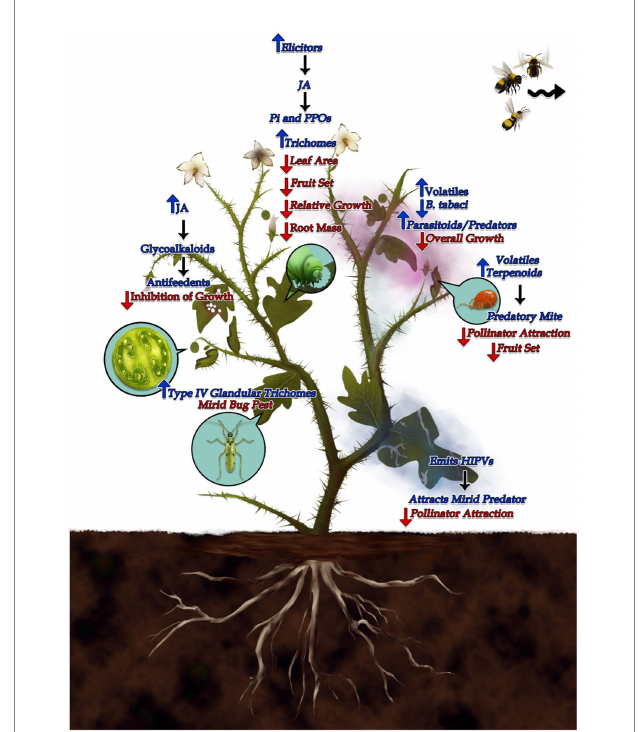
FIGURE 1 Schematic representation of the plant defense mechanisms to the herbivores belonging to different types of feeding guilds and the trade-offs associated with them. As the plant defenses are expensive, plants display a balance between the allocation of their limited resources for growth and defense. Plants under attack of leaf chewing herbivores generally lead to activation of Jasmonic acid signaling pathways which then emits various Herbivore induced plant volatiles (HIPV’s), which can act as antifeedants and also can act as cues for predators or parasitoids. These defensive volatiles can be produced either locally or systemically and can be flavonoids, terpenoids and alkaloids (Wasternack and Parthier, 1997). For instance, plants of family Solanaceae secrete Glycoalkaloids on infested by Leptinotarsa decemlineata , which acts as antifeedant for these herbivores (Pelletier and Tai, 2001). Tomato plants infested by leaf minor, Tuta absoluta emits Herbivore induced volatiles (HIPV) induced by Jasmonic acid, which attracts three mirid predators, Macrolophus basicornis (Stal), Engytatus varians (Distant), and Campyloneuropsis infumatus (Carvalho; Silva et al., 2018). In another example, on infestation by two-spotted spider mite, Tetranychus urticae , the tomato plants emitted volatile tarpenoids which attracted the predatory mite, Phytoseiulus persimilis (Kant et al., 2004). The defenses induced by Jasmonic acid, comes with a cost. Plants on attack by Manduca sexta , increased the levels of JA induced defense chemicals namely, polyphenol oxidase and peroxidase, however it leads to lower fruit set as well as lesser seed set (Redman et al., 2001). Likewise, plants of Solanum carolinense , when treated with Jasmonic Acid, showed lower relative growth, less root mass along with less aboveground mass (Walls et al., 2005). It was reported that the HIPV’s (Herbivore Induced Plant Volatiles) induced in Solanum peruvianum decreased the pollinator attraction and hence less seed set was observed in plants. Moreover, the bees used those volatiles cues to avoid herbivore infested inflorescences (Kessler et al., 2011). When it comes to phloem feeders, the defense signaling is mainly induced by Salicylic acid pathway. For example, plants under attack of aphids, Myzus persicae deter the attack by Bemisia tabaci and emit volatiles which tend to attract various general as well as aphid specific natural enemies (Tan and Liu, 2014). Interestingly, Datura wrighti exhibit a trade-off between plant resistance to whitefly and susceptibility to mirid bug, Tupiocoris notatus where the glandular trichomes inhibit the colonization of whitefly but increases the oviposition by T. notatus (Van Dam and Hare,